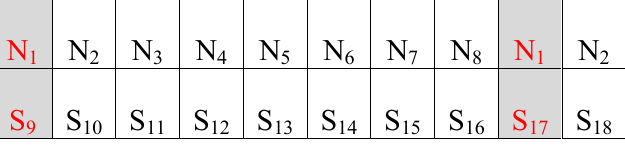
Fig. 6 Critical data selection of each frame using module